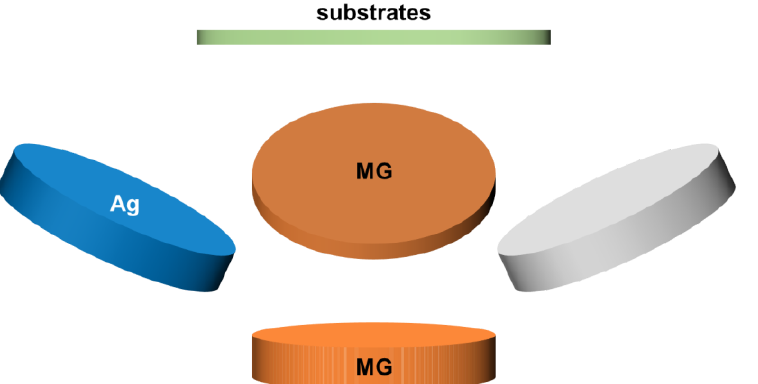
Figure 1. Schematic of target positioning in the ultra-high vacuum (UHV) chamber. The grey disc, on the right-hand side, represents the fourth magnetron of the chamber which was not used during depositions.